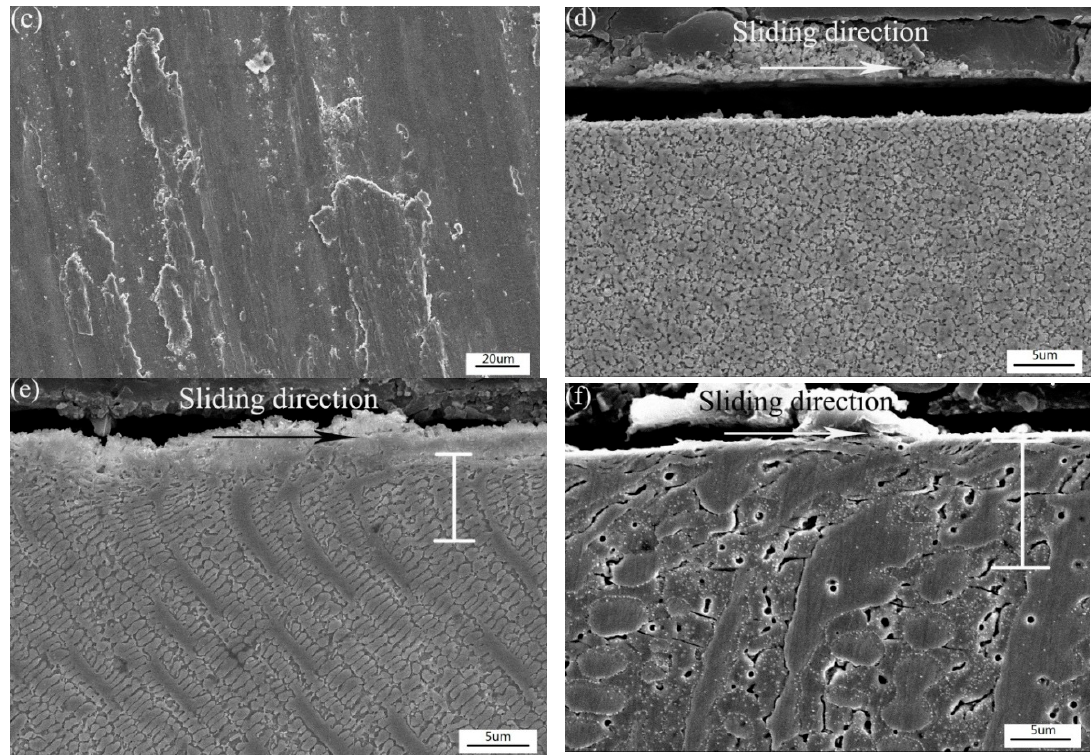
Figure 14. SEM micrographs showing the worn surfaces and sections perpendicular morphologies of Coating 1 ( a , d ), Coating 2 ( b , e ) and Coating 3 ( c , f ).